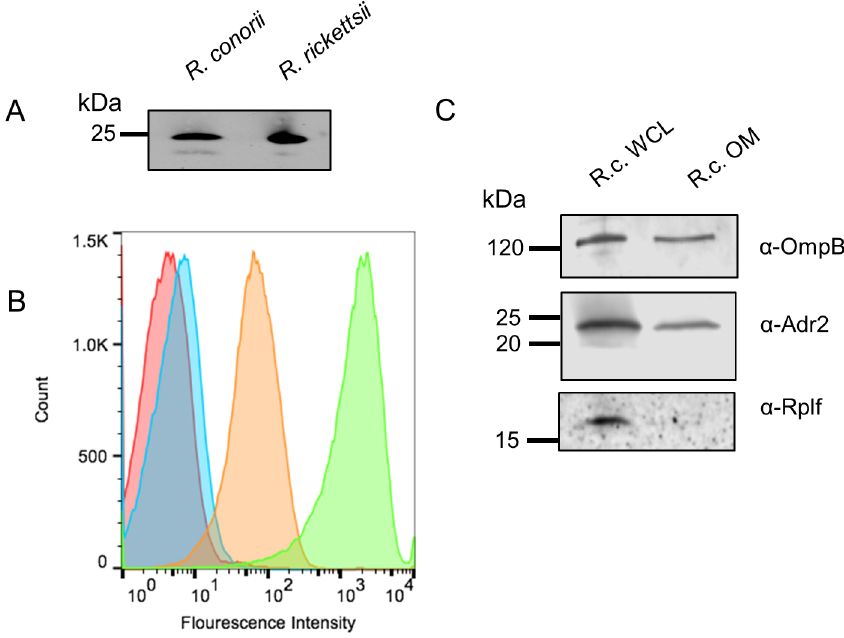
Fig 2. Outer-membrane expression of Adr2 in R . conorii . (A) Western blot analysisusing rabbit-anti-Adr2 antiserum confirms the expression in R . conorii Malish 7 and R . rickettsii SheilaSmith wholecell lysate (WCL). (B) Flow cytometry confirmedthe expressionof Adr2 at the surface of R . conorii .A shift in fluorescence is observed when fixed R . conorii was incubatedwith primary and secondary antibodies (orange)comparedto samples preparedwith only primary or secondary (red and blue, respectively). A sample is incubatedwith Anti- R . conorii serum (green)as a positive control of the flow cytometer. (C) Western blot analysisof R . conorii wholecell lysates (WCL) and outer-membrane(OM) preparations using antibodies againstOmpB (mAb 6B6.6) or Adr2 demonstrates the presence of reactive species in both WCL and OM preparations. Anti-RplF (50s ribosomalprotein L6) is used a control for cytoplasmic contents.